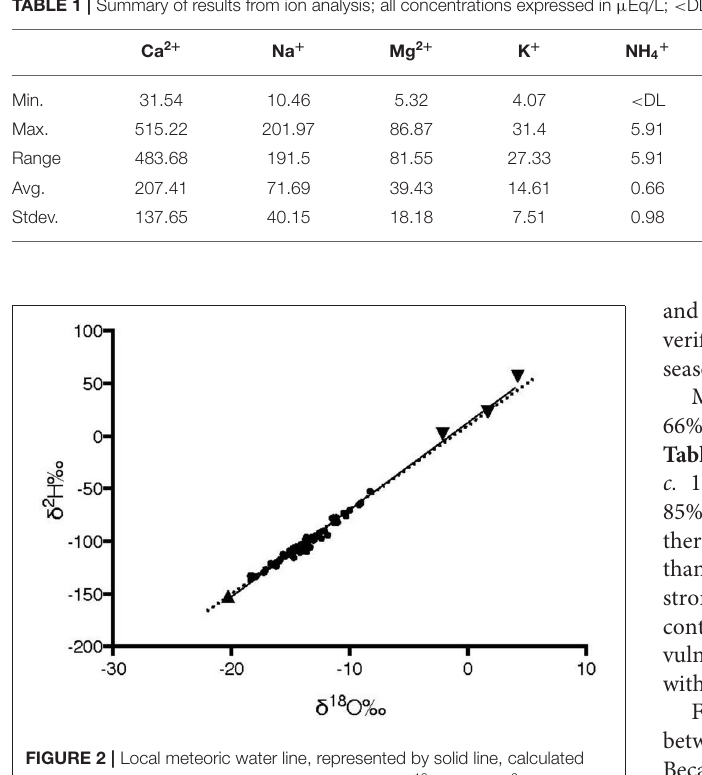
FIGURE 2 | Local meteoric water line, represented by solid line, calculated from isotopic ratios of collected samples; LMWL is δ 18 O = 8.27 δ 2 H + 12.7 ‰ ; point-up triangle represents glacial melt sample; point-down triangles represent rain samples; circles represent all other sampling locations; global meteoric water line ( δ 18 O = 8 δ 2 H + 10 ‰ ) is represented by dotted